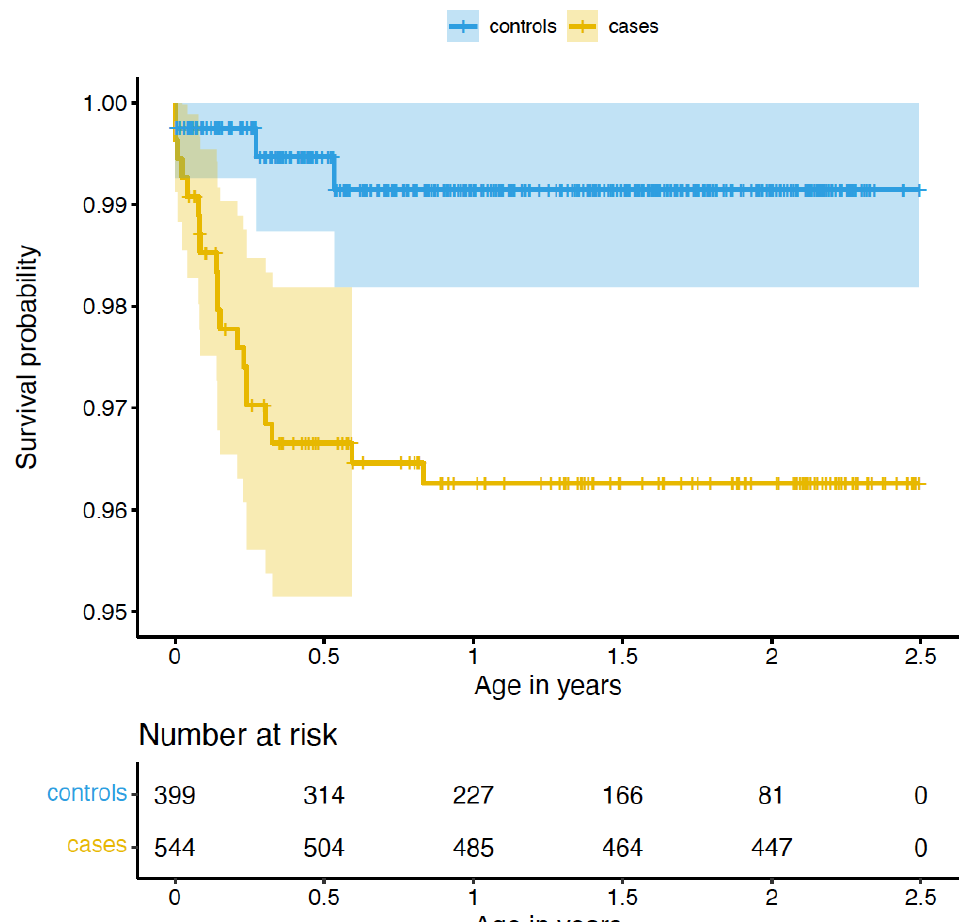
Figure 1. Survival curve for congenital malformations of the circulatory system compared between cases and controls. ‘Number at risk’ indicates the number of cases and controls available for analysis at 0–2.5 years of age. As cases presented with significantly longer follow-up time compared to controls, we limited the follow-up time of cases to the age of the eldest child in the control group (see also Methods).